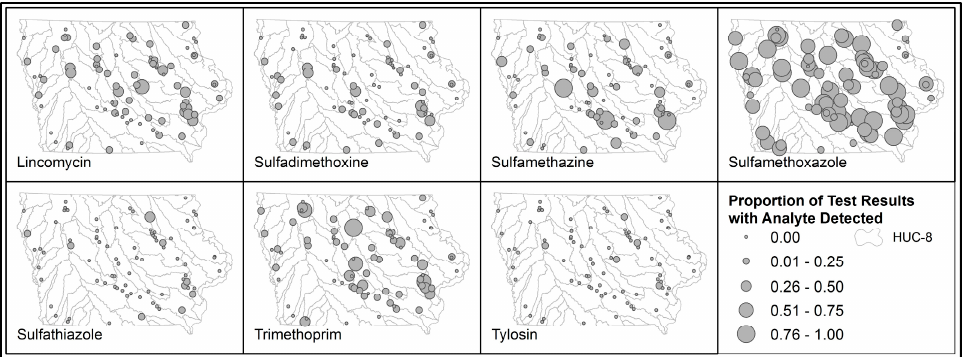
Figure 8. Locations of sites testing water quality in Iowa, with the proportion of samples testing positive for each of seven antibiotics.